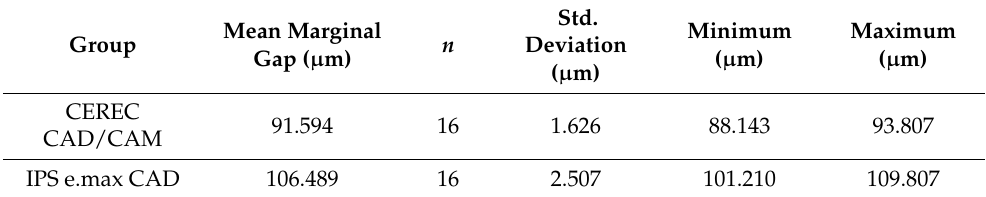
Table 1. Descriptive statistical results for the tested groups.